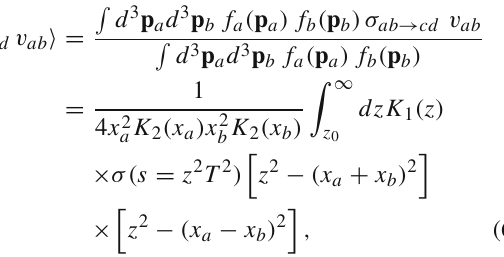
Fig. 4 Thermally averaged cross sections for monopole pair annihi- lation M ¯ M → q ¯ q as a function of x = M / T , with different values of the monopole mass M . Plots in the top and bottom panels describe spin-zero and spin-half monopoles,